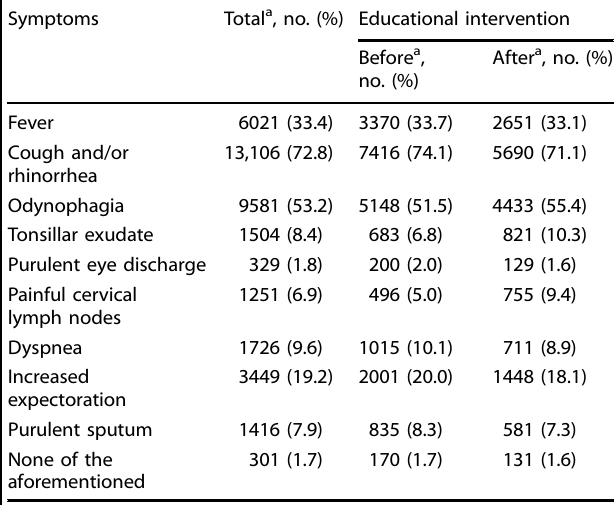
Table 2. Changes of symptoms of acute respiratory tract infection before and after the physician ’ s educational intervention.